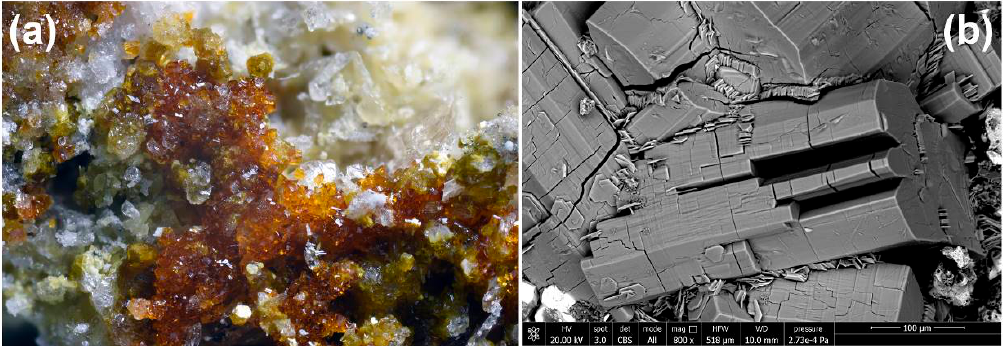
Figure 11. Giacovazzoite, as orange-brown prismatic crystals ( a ), associated with yellow-green scordariite and alum-(K). Field of view = 3 mm. A detail of the morphology of the crystals of giacovazzoite is shown in the SEM photo ( b ); thin tabular hexagonal crystals of a metavoltine-related mineral are also present.